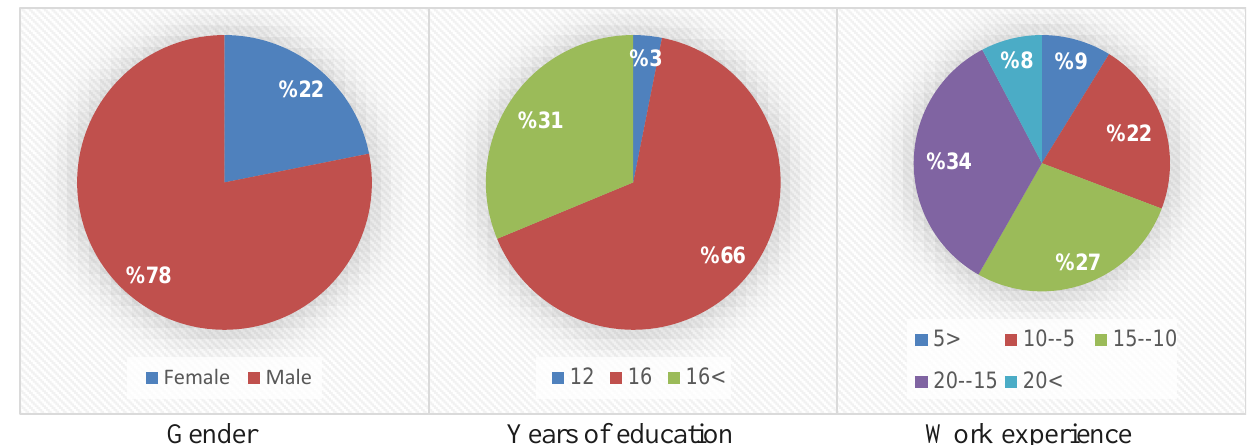
Fig. 2. Personal characteristics of the